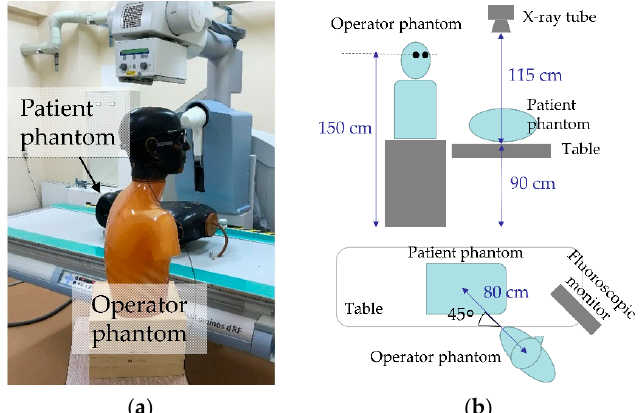
Figure 4. An experimental setup for eye lens dose measurement that simulated an ERCP physician. The operator phantom was turned toward a fluoroscopic monitor: ( a ) photograph and ( b ) schematic of the experimental setup.